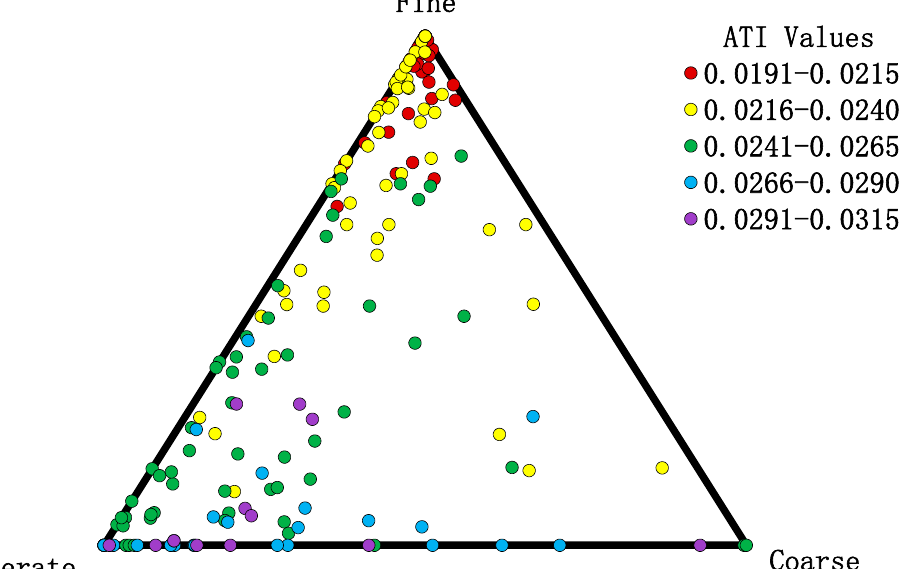
Figure 8. Ternary plot of the areal percentages of each of the three particle size categories within each ATI pixel showing the variation over North Coulee. The peak of each axis corresponds to a 100% areal percentage of the corresponding category. The colored sample interval for the ATI values is derived by five equal divisions.